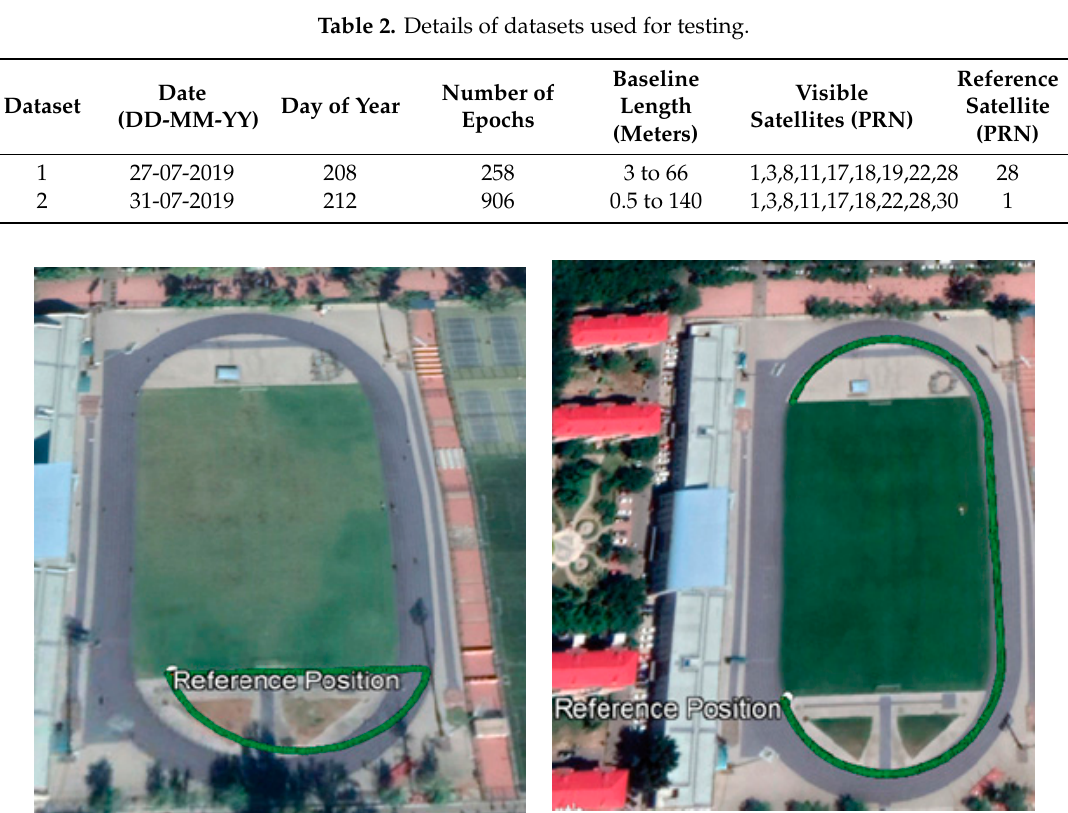
Figure 4. Rover receiver trajectory for dataset 1 ( left ) and dataset 2 ( right ).